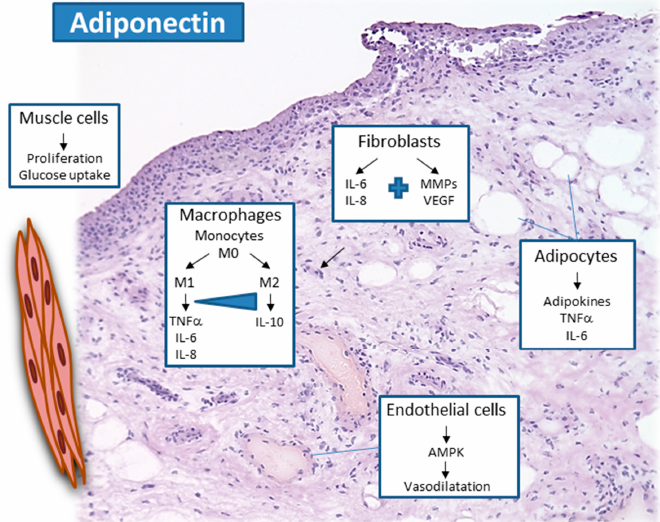
Figure 1. Adiponectin activates local synovial cells, such as synovial macrophages and synovial fibroblasts in the lining layer and sublining, as well as endothelial cells and adipose tissue and muscle in the deeper and adjacent areas of the joint.